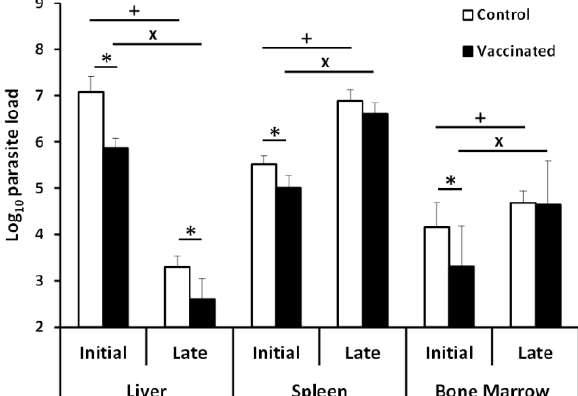
Figure 2. Parasite load monitoring in the liver, spleen, and bone marrow. The presence of viable parasites of the PpyRE9h + L. infantum line in control and vaccinated mice was analyzed by limiting dilution in the presence of puromycin at week 5 (initial phase; n = 8) and at week 11 (late phase; n = 8) after challenge with 10 8 promastigotes. Samples from each mouse were processed and analyzed independently. The graph shows the mean ( + SD) of parasites per g in the liver, spleen (total organ), or parasites per 1 × 10 7 bone marrow cells. * ( p < 0.05) shows the statistical di ff erences between control and vaccinated mice. + ( p < 0.05) shows the statistical di ff erences between the initial and late phases of control mice. × ( p < 0.05) shows the statistical di ff erences between the initial and late phases of vaccinated mice. All samples were analyzed using a Student T test. Results are representative of at least two independent